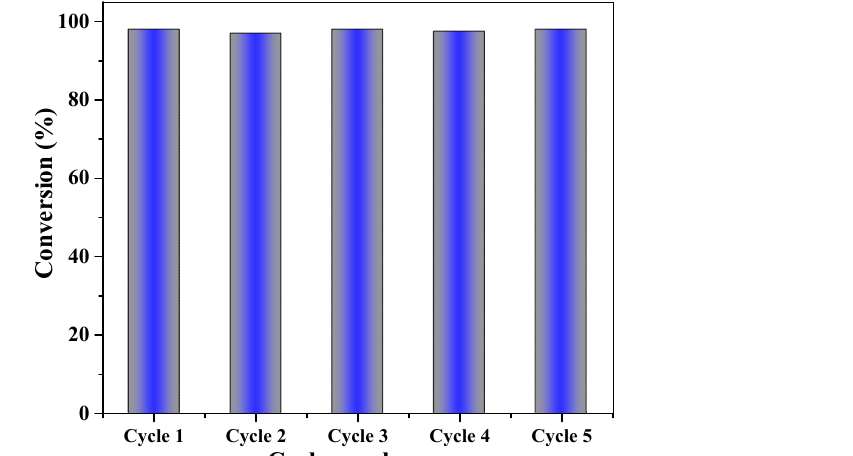
Figure 6. Recycling experiment using 10% Ni@CSs composite catalyst in cyclohexene epoxidation (50 mg catalyst, 353 K, pH = 8, and 14 h).